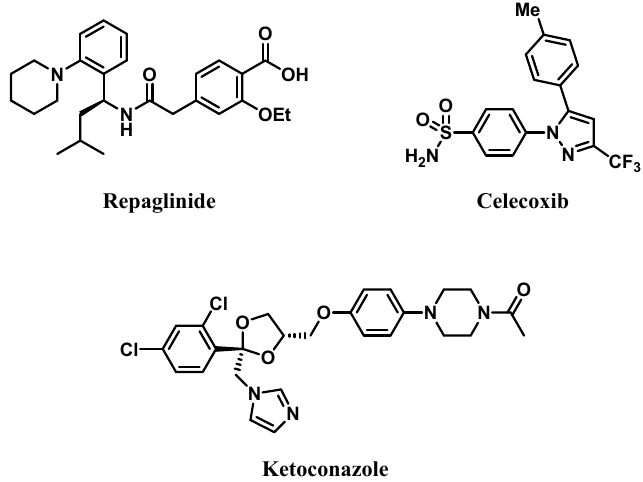
Figure 1. Chemical structures of repaglinide, celecoxib, and ketoconazole (internal standard, IS).